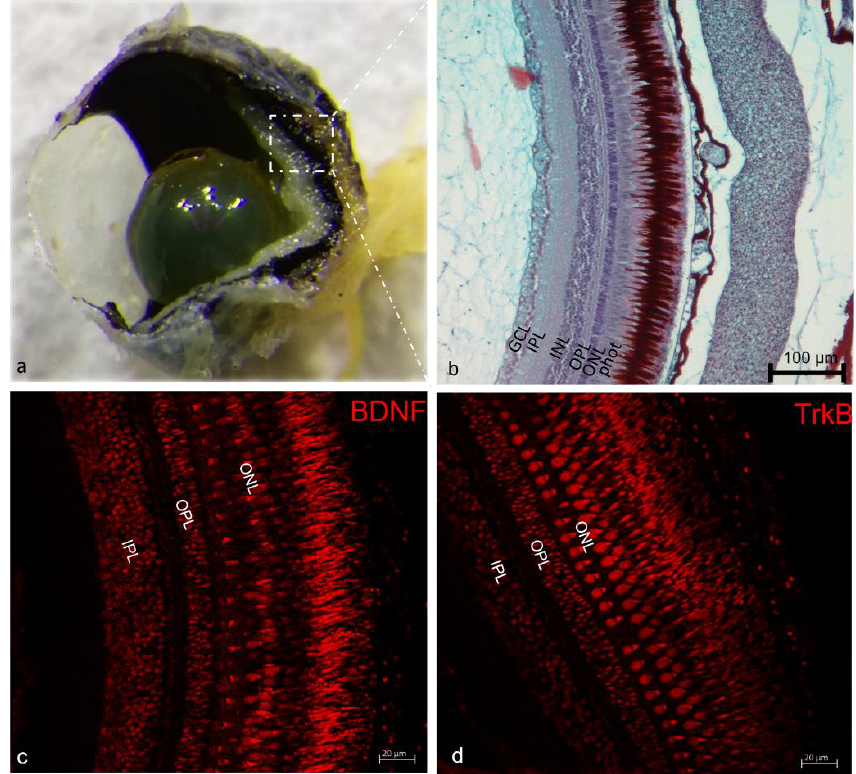
Figure 3. Stereomicrograph of zebrafish eye ( a ). Longitudinal section of zebrafish retina stained with Masson Trichrome with aniline blue, ganglion cell layer (GCL); inner plexiform layer (IPL), inner nuclear layer (INL), outer plexiform layer (OPL), outer nuclear layer (ONL), photoreceptor cell segment (phot); ( b ). Immunohistochemical localization of BDNF; ( c ) and TrkB; ( d ) in zebrafish retina layer. BDNF immunoreactivity was observed in the outer nuclear layer (ONL), outer plexiform layer (OPL) and inner plexiform layer (IPL), whereas TrkB immunoreactivity ( b,d ) was restricted to the inner plexiform layer (IPL). Magnification 20× ( b ); 40× ( c , d ). Magnification 20× ( d ), 40× ( c , d ).